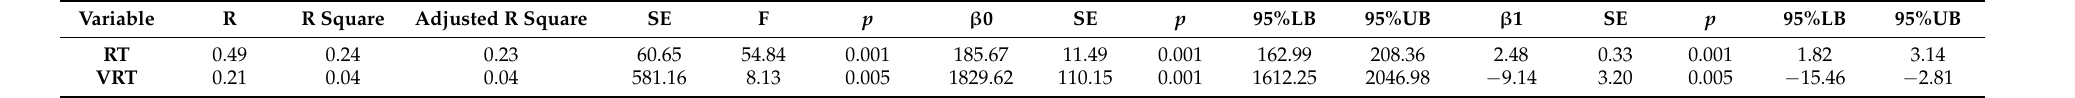
Table 5. Model summary, ANOVA report and coefficients for simple linear regression analysis—age versus RT and VRT ( n = 180).